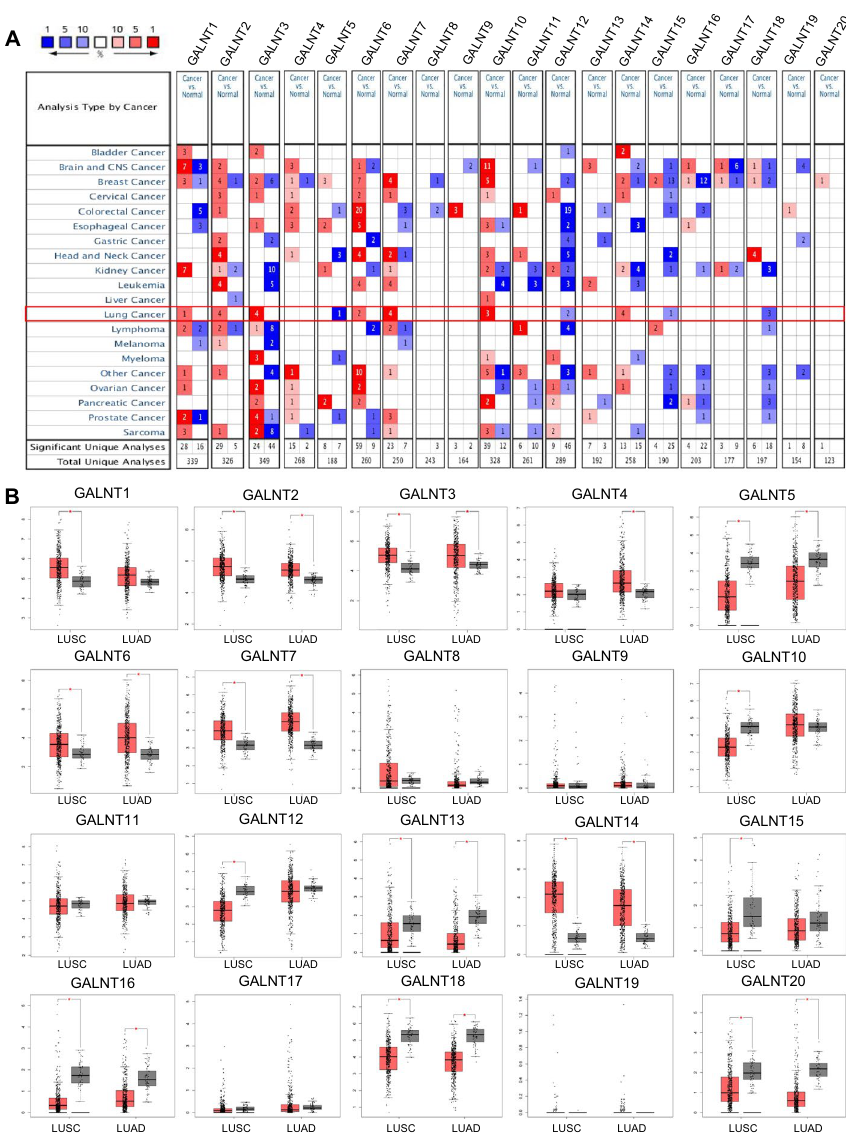
Fig. 1 Gene expression profiles of the GALNT family members in NSCLC. A Oncomine analysis of GALNT mRNA expression. Red: up-regulation; blue: down-regulation. The number in the colored cell represents the number of datasets meeting the threshold ( P -value, 0.05; fold change, 2; gene rank, top 10%). B Analysis of GALNT mRNA expression in TCGA. Red box represents tumor tissues and grey box represents normal tissues. * P <